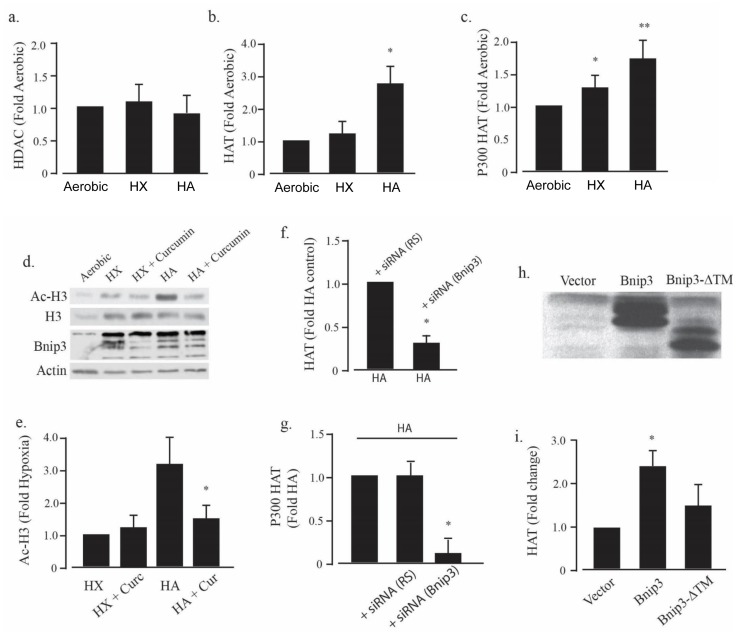
Bnip3 increases p300 acetyltransferase activity.Histone deacetylase (HDAC) (A) and acetyltransferase (HAT) (B) activities were measured in cardiac myocytes exposed to aerobic, hypoxia (HX) and hypoxia-acidosis (HA) as described in Methods. P300-specific acetyltransferase activity is shown in (C). The effect of the p300 inhibitor, curcumin, on histone H3 acetylation (Ac-H3), and Bnip3 protein levels during hypoxia and HA is shown in (D). Western blot quantitation of histone H3 acetylation levels in the presence of curcumin (Cur) is shown in (E). In (F and G), cardiac myocytes were treated with random (RS) or Bnip3 specific siRNA and total cellular HAT (F) or p300 specific HAT (G) activities were determined during hypoxia-acidosis (HA). In (H and I) recombinant Bnip3 or transmembrane deletion mutant Bnip3 (Bnip3-ΔTM) protein were incubated with nuclear lysates from normoxic cardiac myocytes as described in Methods and the HAT activity determined. Results are mean ± S.E.M., * significantly different then controls (p < 0.05), n = 3.